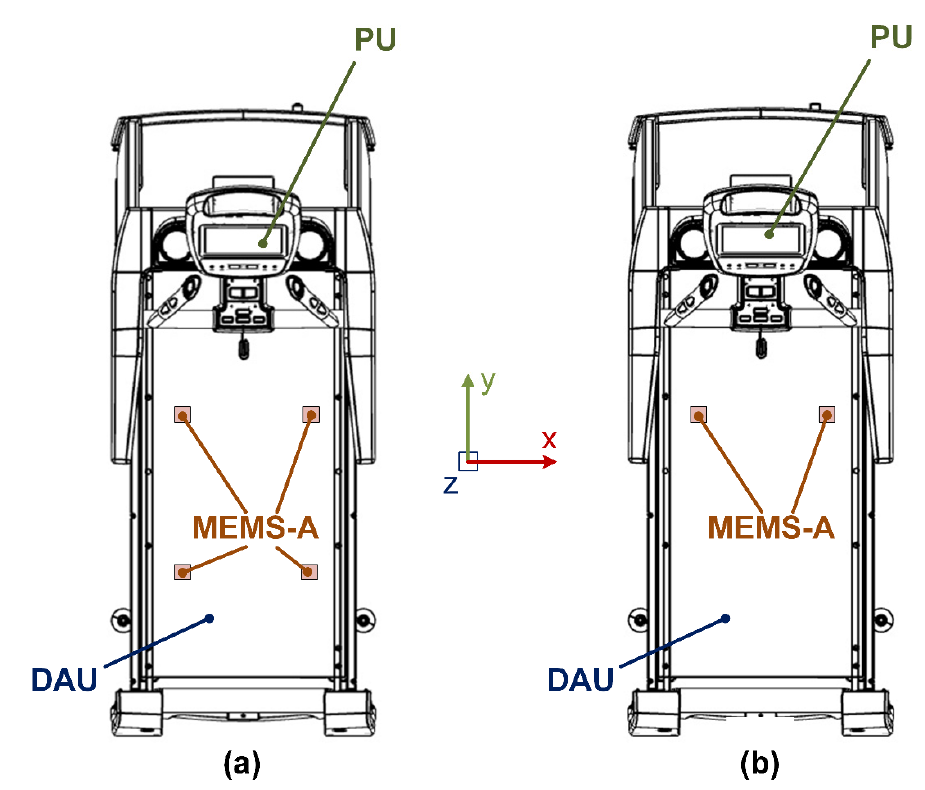
Figure A1. Location of accelerometers (MEMS-A), data acquisition unit (DAU), and processing unit (PU) on the treadmill (AccTrea): ( a ) Four-accelerometer approach; ( b ) two-accelerometer ap-